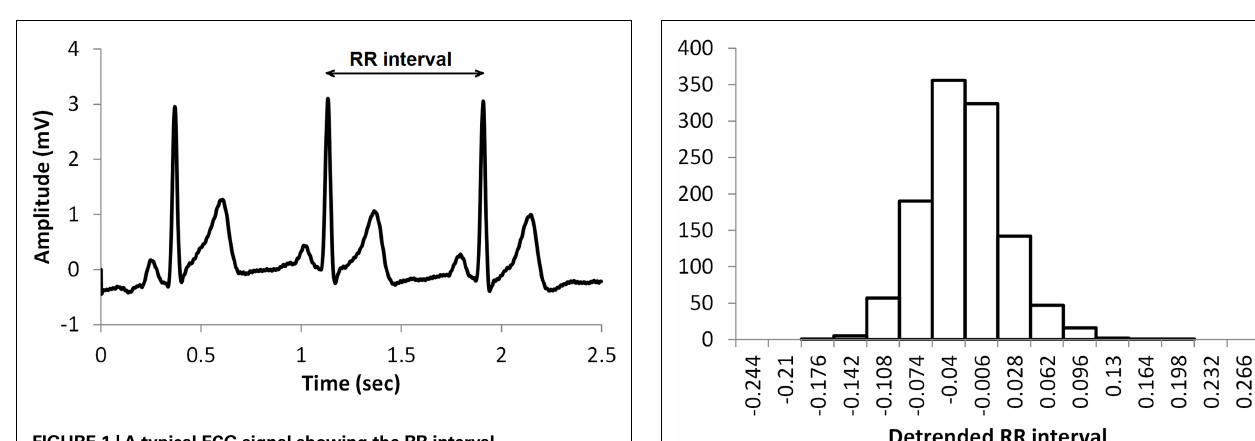
FIGURE 1 |A typical ECG signal showing the RR interval .